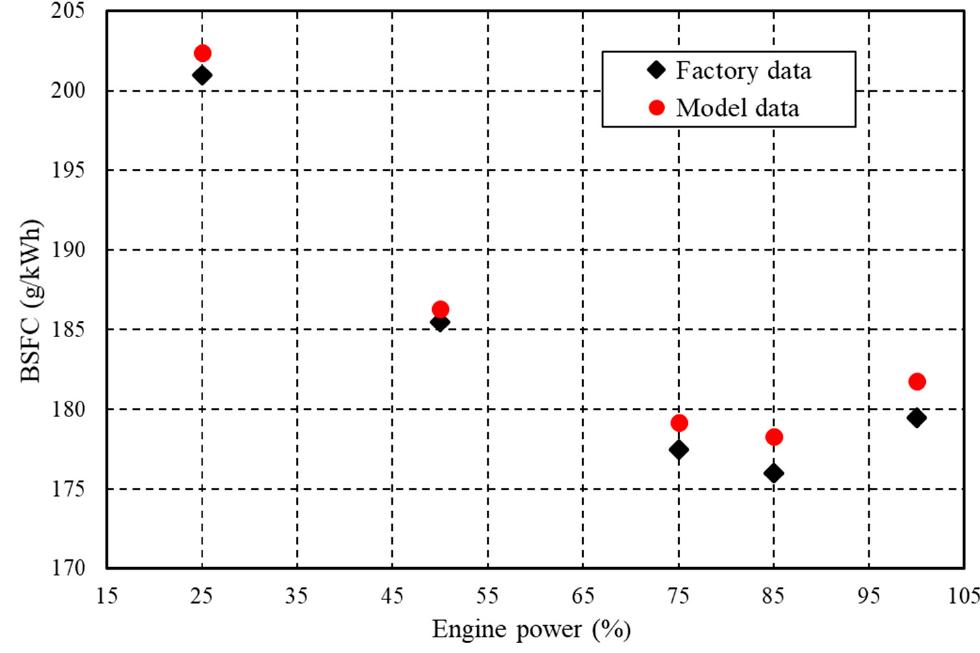
Figure 10. Specific fuel consumption of the MAN 12V48/60CR diesel engine in the range from 25% Figure 10. Speci fi c fuel consumption of the MAN 12V48/60CR diesel engine in the range from 25% to 100% to 100% MCR.